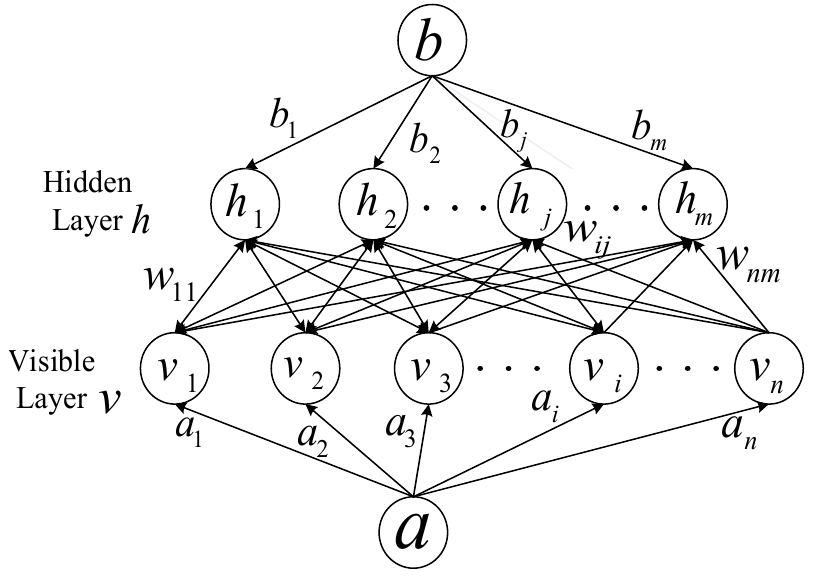
Figure 1. Structure of restricted Boltzmann machine.